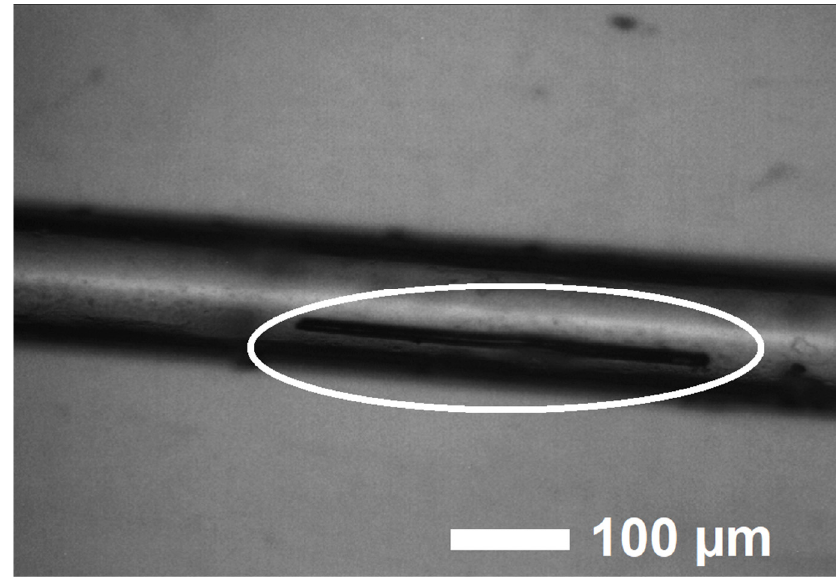
Figure 1. A single crystal of EuScCuSe 3 placed in a glass